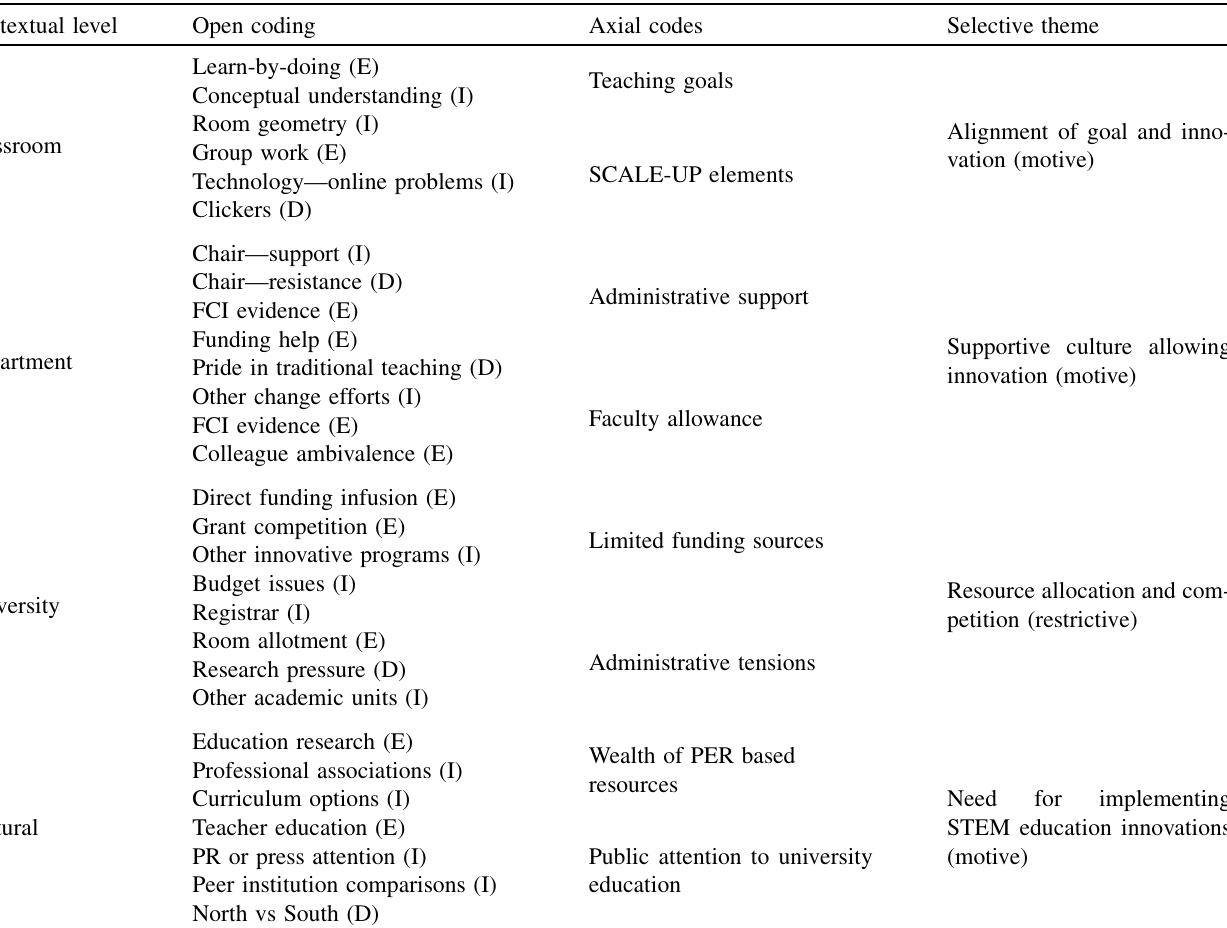
TABLE I. Example codes used during the three phases on constant comparison data analysis (I—initial coding scheme, E—emerged during analysis, D—discarded during